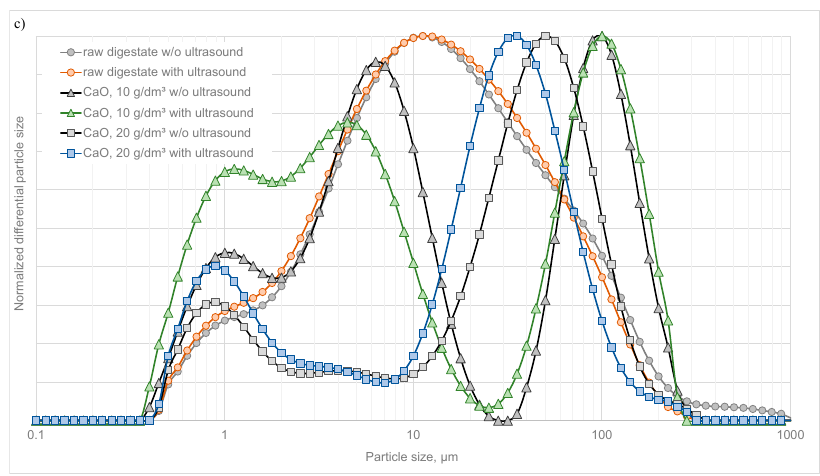
Figure 4. Normalized differential particle size distribution for raw digestate and solution after treatment using FeCl ₃ ·H ₂ O ( a ), PIX 112 ( b ) and CaO ( c ) (pump speed: 2000 rpm, ultrasonic power: 150 W).